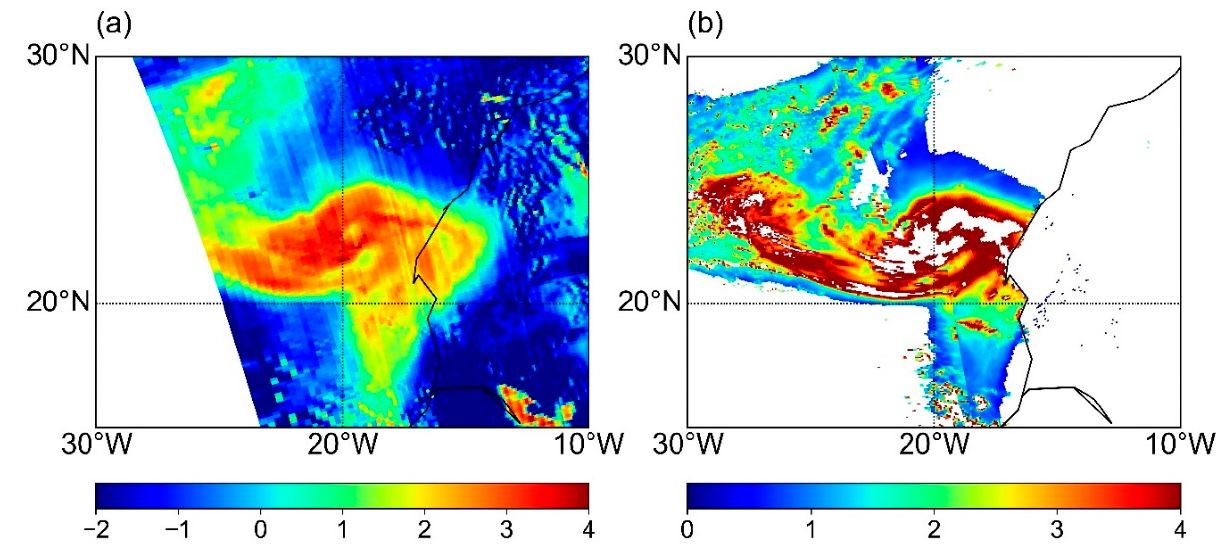
Figure 8. The spatial distribution of AAI results for EMI ( a ) and AOD from TROPOMI ( b ) over the Sahara region on 26 August 2019.